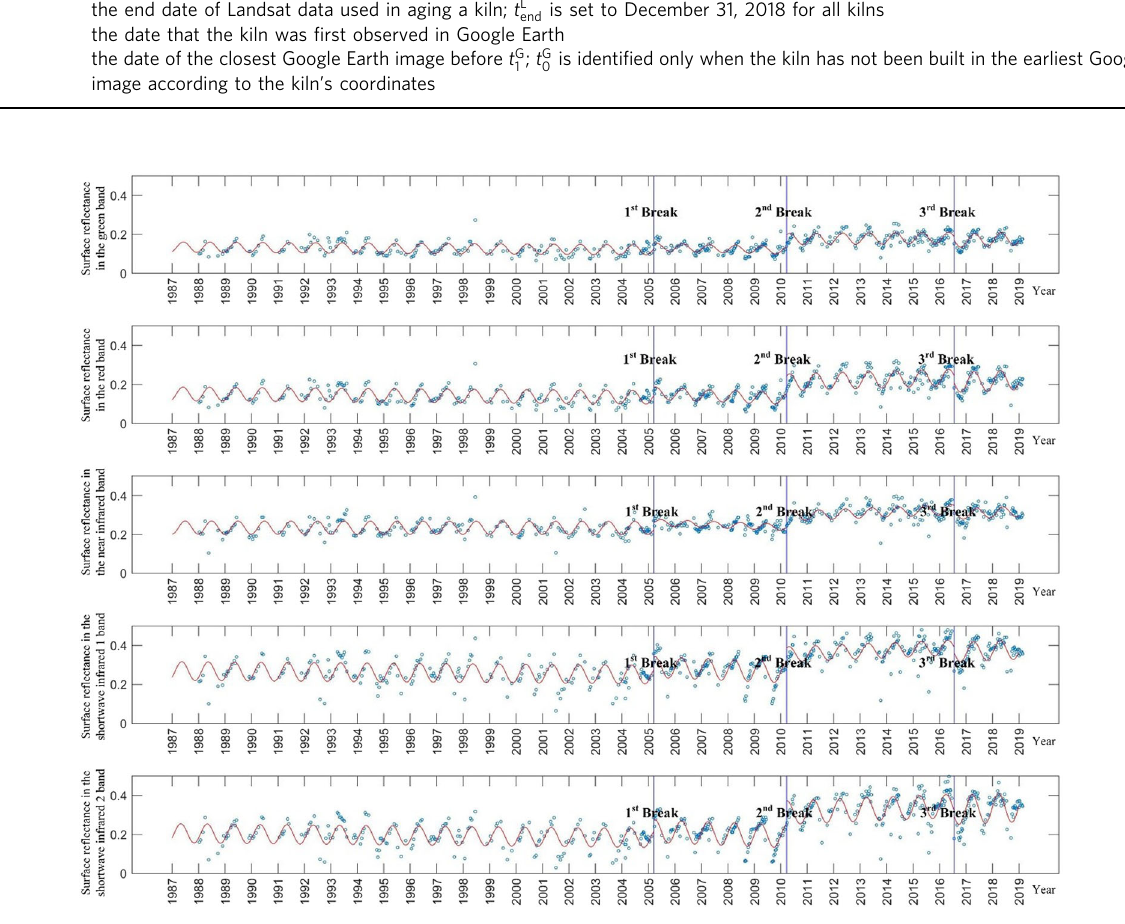
Fig. 2 The break point detection of a Landsat time series in fi ve bands in determining when the Bull ’ s Trench brick kiln — 24°41 ’ 15 ” N, 84°30 ’ 24 ” E — was constructed in Bihar, India. The blue circles represent the surface re fl ectance values, and the red curves represent the fi tted time series